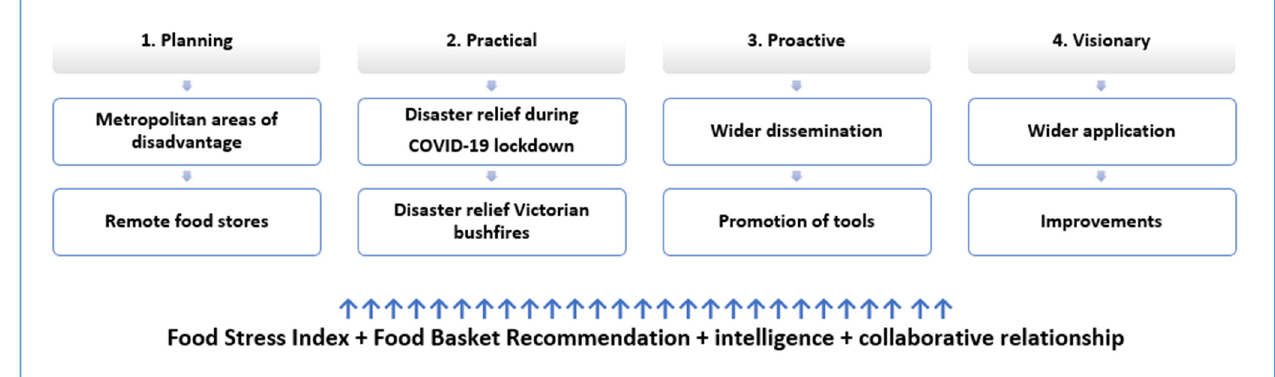
Figure 2. The stages of the process of how the Food Stress Index and food basket recommendations were applied by emergency food relief providers.